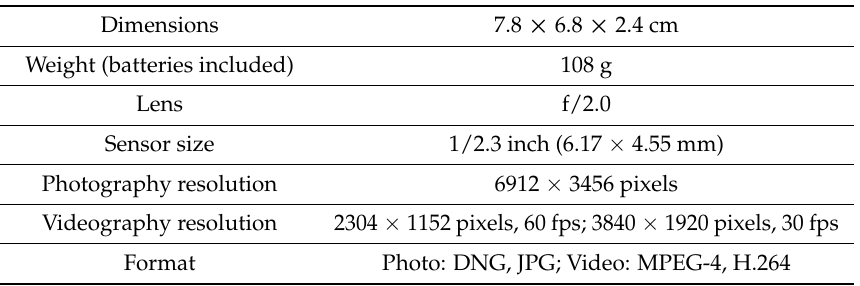
Table 1. Specifications of the employed camera.